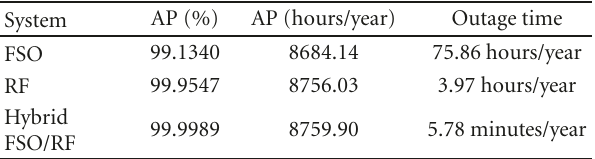
Table 1: Availability performances of FSO, RF, and simulated hybrid FSO/RF